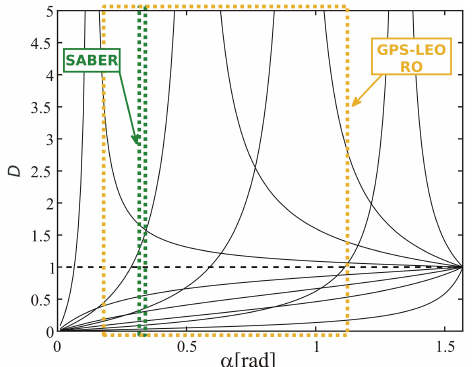
Figure 6. The α ranges corresponding to both experimental se- tups, are defined within dash-dotted colored boxes. These ranges are [0.17–1.22] rad and [0.32–0.34] rad, respectively in yellow and green, for GPS-RO and SABER, according to Fig. 5. The curves already selected in Fig. 2a and b for successive and constant ψ val- ues ( (cid:49)ψ step = 0 . 4) between 0.1 and 2.9, are included in black for reference